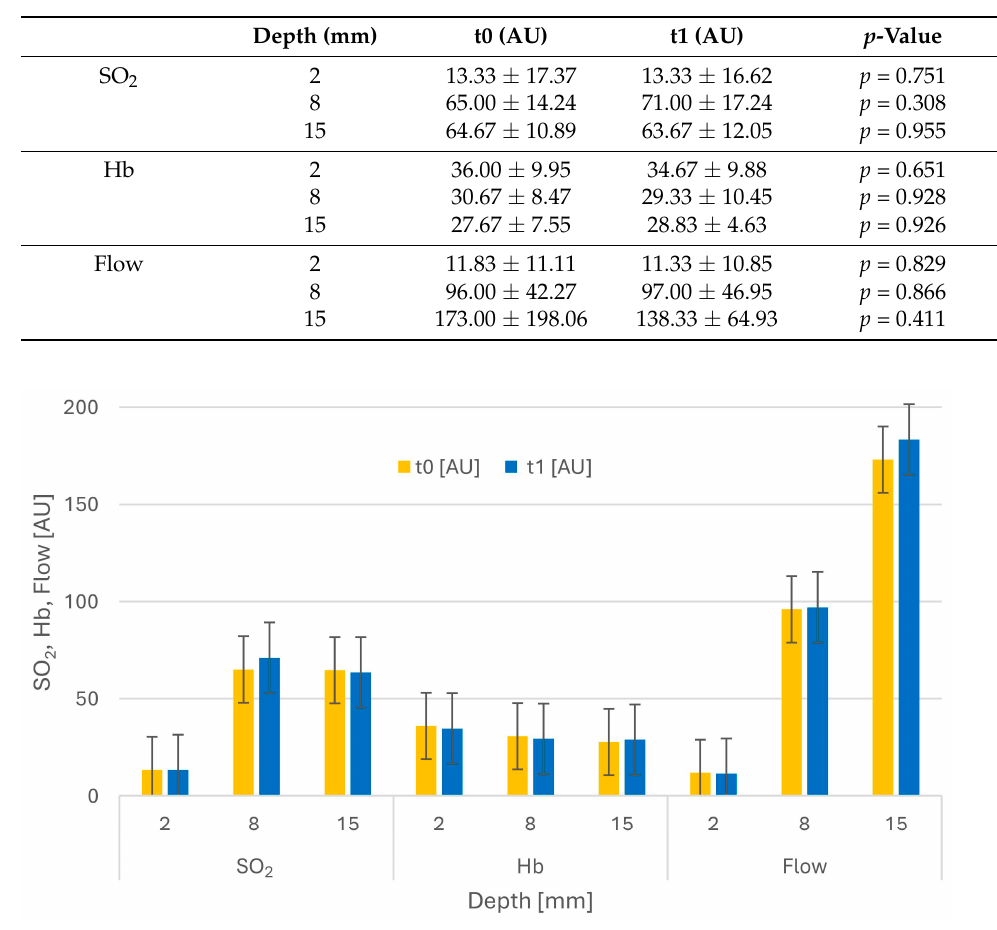
Table 1. Overview of mean values in arbitrary units (AU) with SD of the time points t0 and t1 in the three different depths and p -values of the one-way ANOVA.